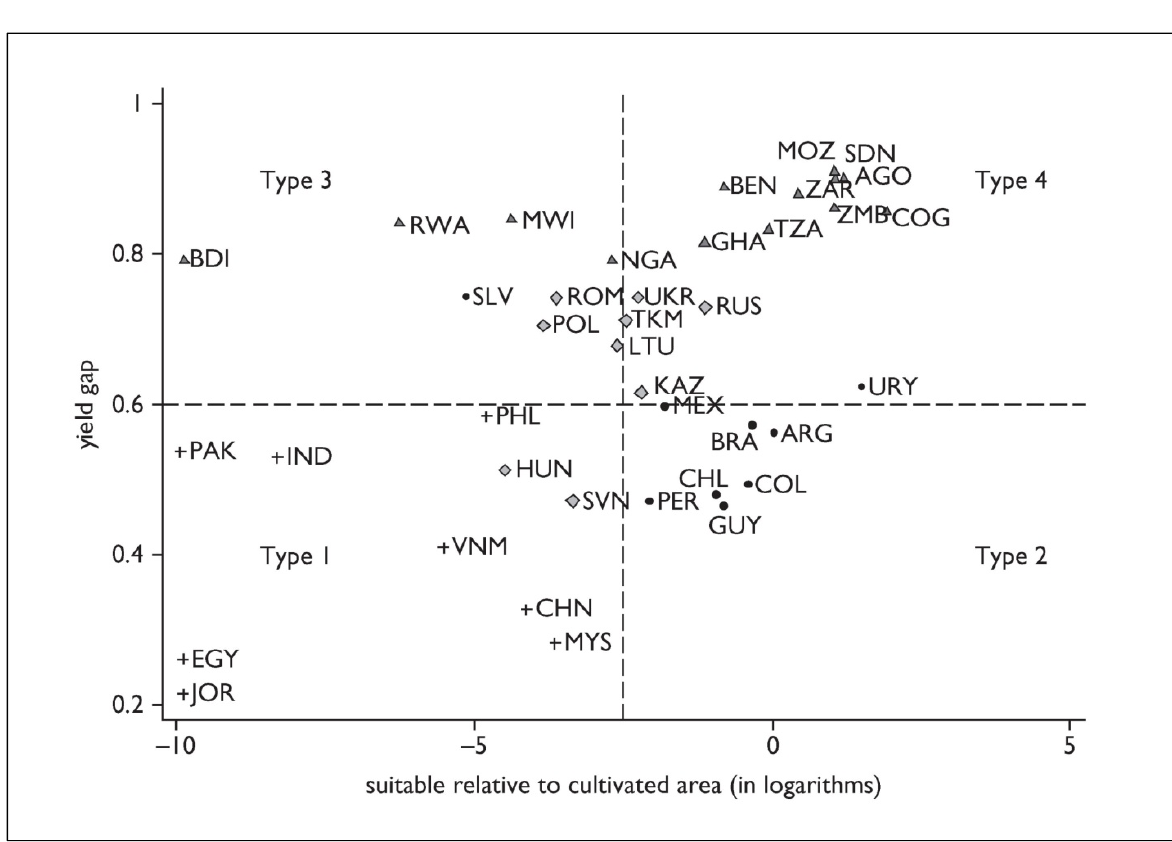
Figure 2. Potential Land Availability vs. Yield Gap for Developing Countries